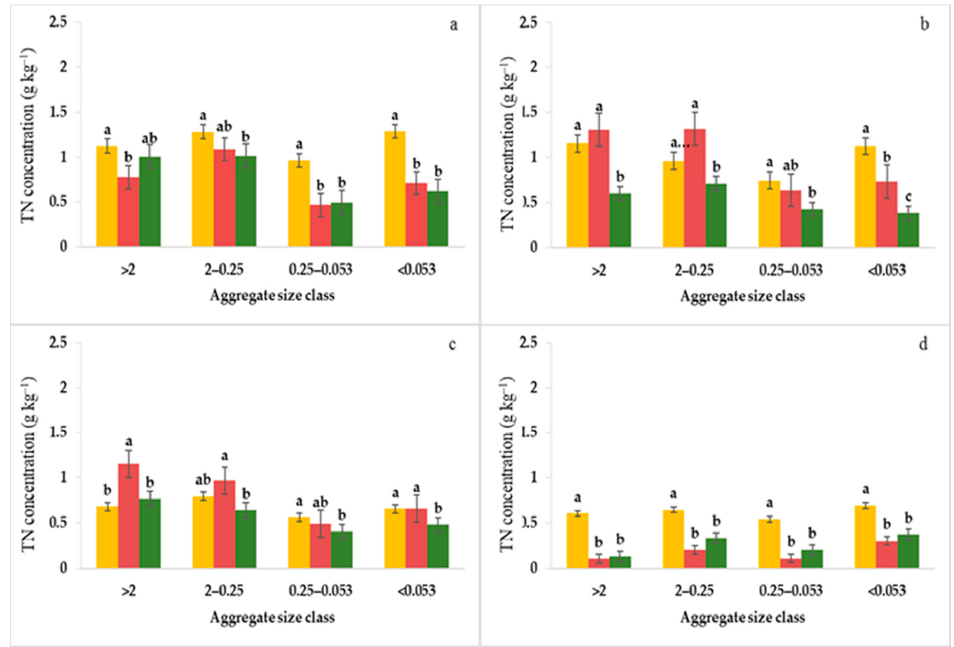
Figure 5. Total nitrogen (TN) concentration (g kg − 1 ) in different size of aggregates for initial situation 5 (CT0; yellow bars), conventional-tillage (CT1; red bars) and no-till (NT+H; green bars) treatments at different horizons for ( a ) Ap horizon, ( b ) Bw horizon, ( c ) BC horizon and ( d ) C horizon. Values are given as mean ± standard error (n = 5). The different lowercase letters above the error bars for the same aggregate fraction indicate significant differences based on post-hoc tests, Tukey’s honestly significant difference (HSD) at p < 0.05 between